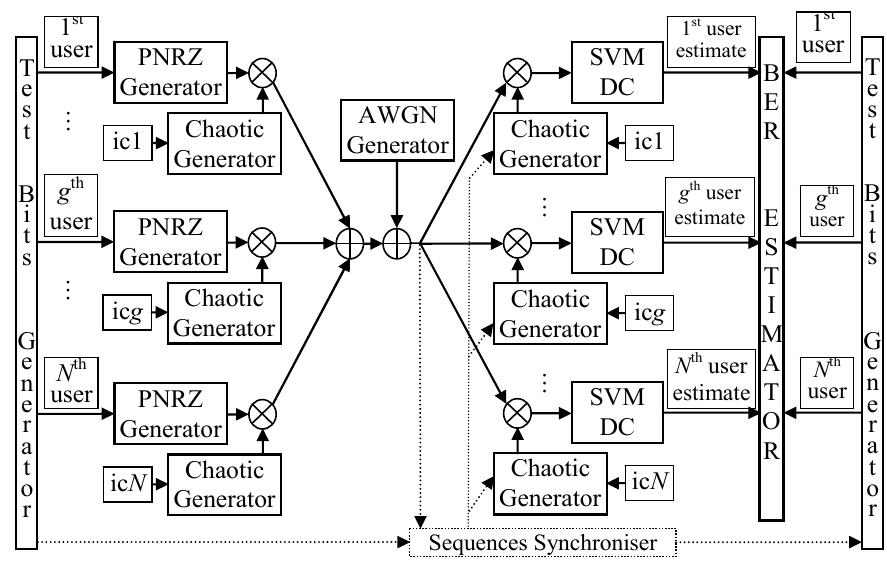
Figure 3 – Structure of the designed and implemented SVM CDMA system Рис . 3 – Структура разработанной и внедренной системы SVM